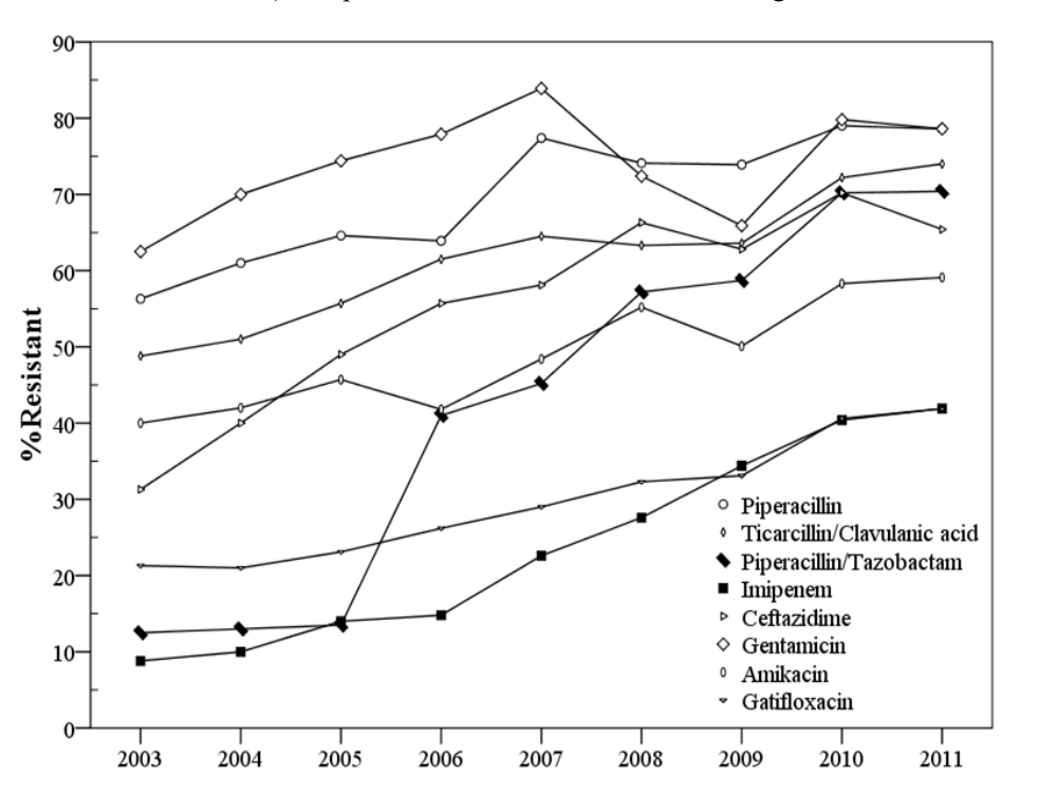
Figure 1. The secular trend of resistance to different antimicrobial agents over the years. Rapid increase of piperacillin/tazobactam resistance ( p < 0.001; OR, 1.415; 95% CI, 1.358 to 1.475) and imipenem-resistance in A. baumannii complex ( p < 0.001; OR,